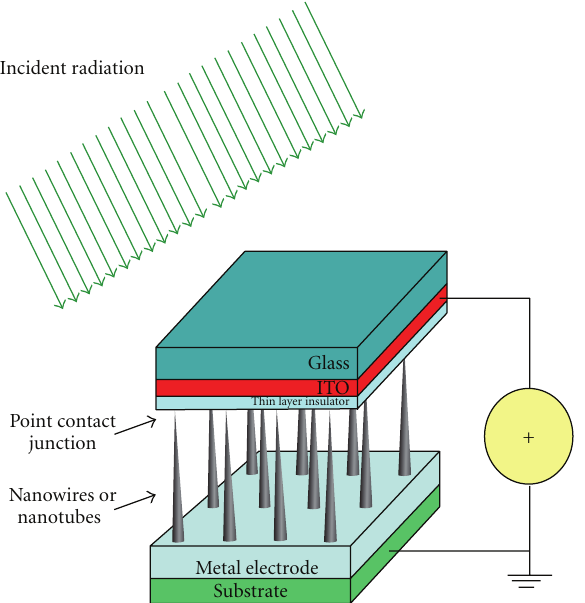
Figure 17: Schematic diagram of the proposed nanowire/CNT based IR sensor. The sharp metallic nanowires/CNTs act as the receiving antennae and the rectifying diodes.